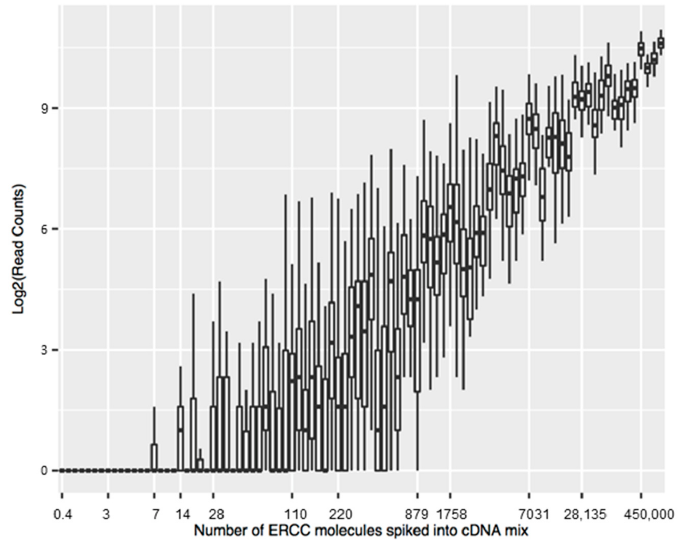
Figure 4. Limit of detection of ERCC. Content from the nanobiopsy of the nucleus was transferred to the cDNA mix (containing 0.5 μ L of ERCC mixture at a 1:10,000 dilution) to reverse transcribe the RNAs followed by DNA sequencing. The sequencing reads were mapped to the ERCC reference pseudo-genome. The number of transcripts were counted using the HTSeq package and plotted as a function of the number of the ERCC transcripts (ERCC concentration × volume × dilution factor). The estimated intersect of the ERCC curve with the X axis was between 7 and 220, which represents at least one detected ERCC transcript. The threshold for detected transcripts was chosen to be 10 for subsequent analysis. (Pourmand Lab, Personal Communication, 2018).